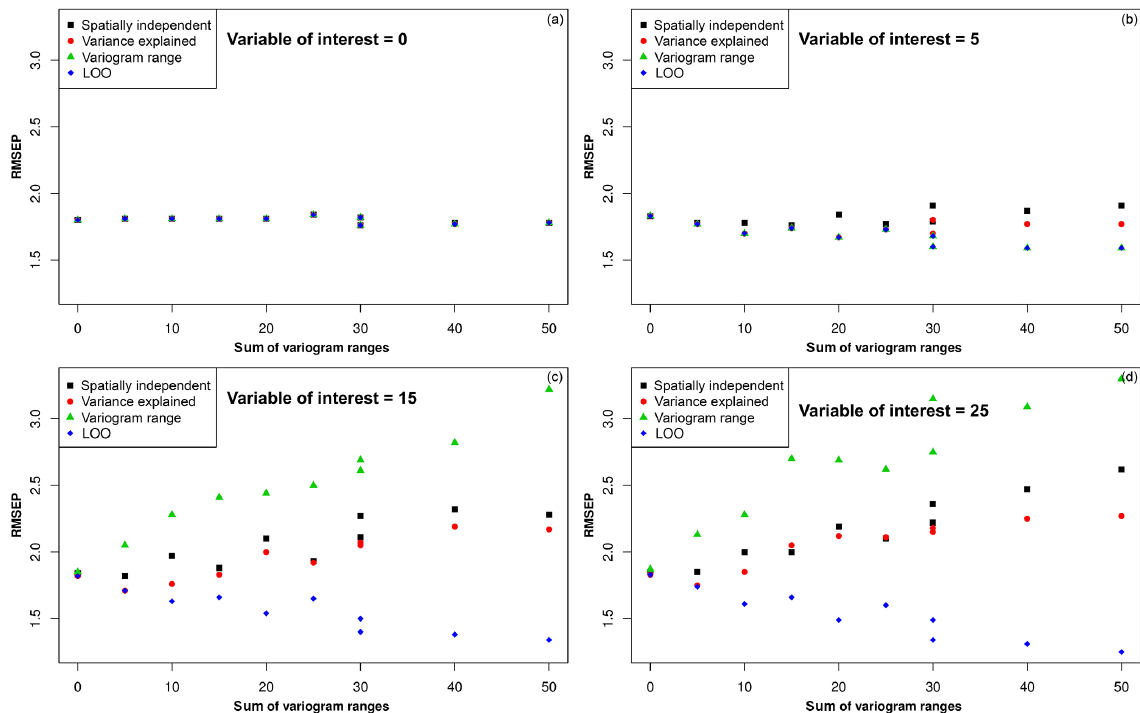
Figure 2. Comparison of root mean squared error of prediction (RMSEP) estimates using modern analogue technique (MAT) transfer functions as functions of autocorrelation. H -block cross-validated RMSEP and leave-one-out (LOO) cross-validated RMSEP are displayed as a function of the sum of variogram ranges of the nuisance variables, i.e. the total spatial autocorrelation increases with increasing values. H was determined using a spatially independent test set as well as the variance-explained method. RMSEPs displayed are medians of 100